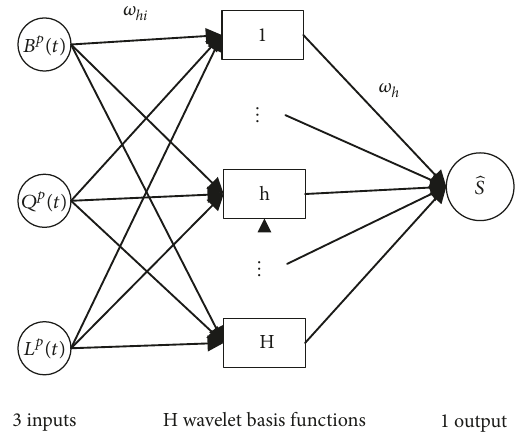
Figure 2: Structure of the wavelet neural network for upper phase.